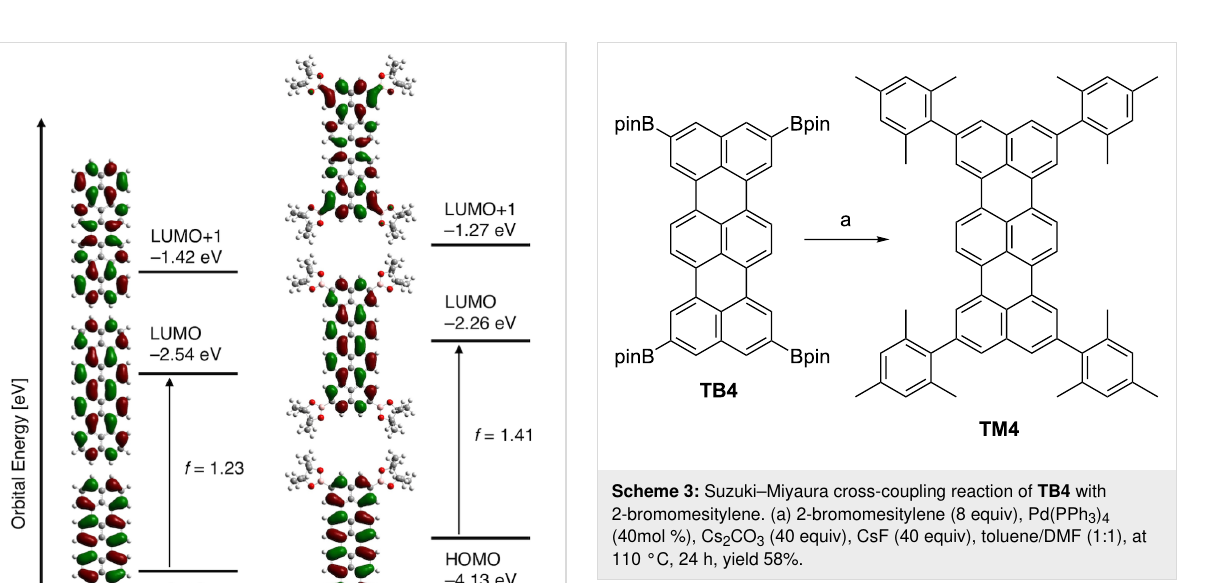
The simulated absorption showed a good agreement with the observed spectra.